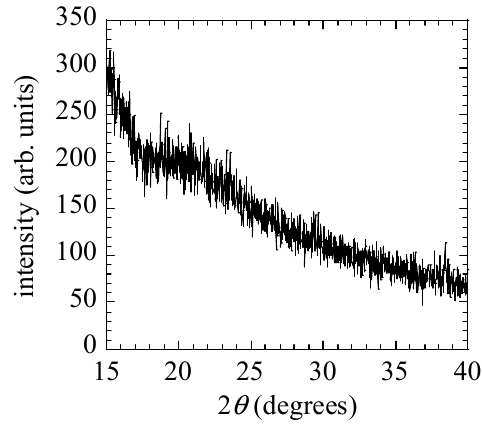
Figure 5. XRD spectrum of CNPs for FR = 50 sccm.